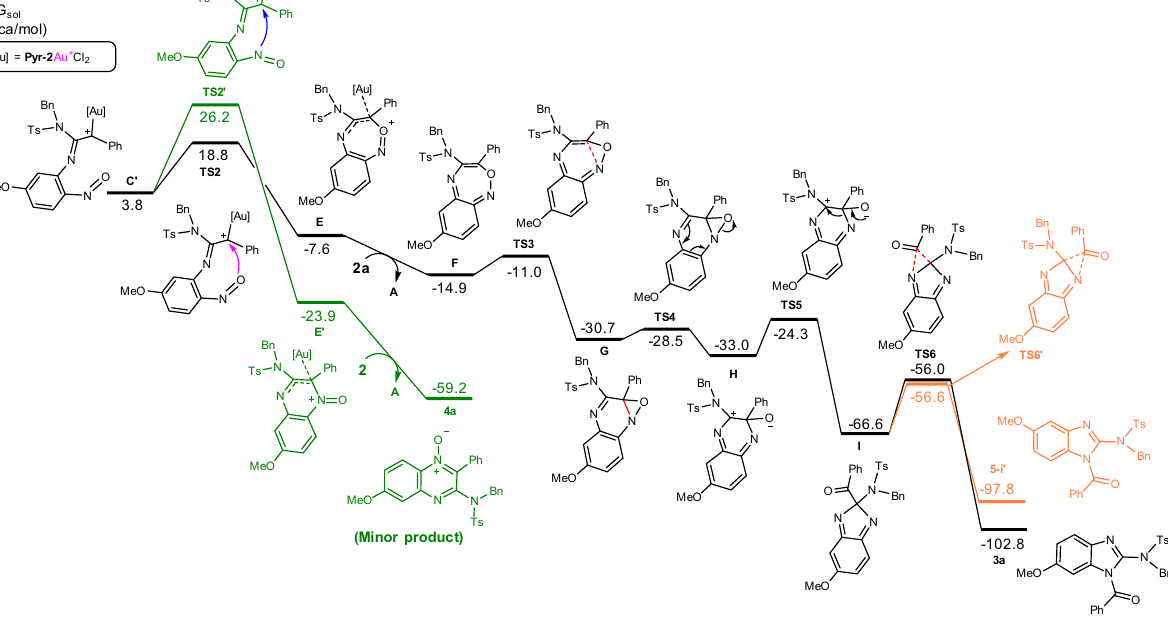
gold(I) catalysts. In contrast to Pt(II) catalysis, the gold(III) complex 6 enables the selective synthesis of benzimidazoles via tandem annulation/ ring contraction/ acyl migration. DFT calculations support the experimentally observed selectivity for gold(III) and Pt(II) systems well. Analysis of geometric and electronic structures of key metal-carbene intermediates reveals that the electronic effect is the main reason for the annulation selectivity. The Au(III) carbene shows carbocation-like character, favoring O -attack, while the Pt(II) carbene prefers forming a six- membered ring via N -attack, which rationalizes the divergent annulation routes. These insight in transition metal catalysis can help to on purpose switch to certain reaction channels of metal- carbene intermediates in future methodology development. Methods Representative procedure for Au(III)-catalyzed tandem annulation . A round bottom fl ask equipped with a magnetic stirrer bar was added 10mol% 2,6- NATURE COMMUNICATIONS| (2022) 13:1672